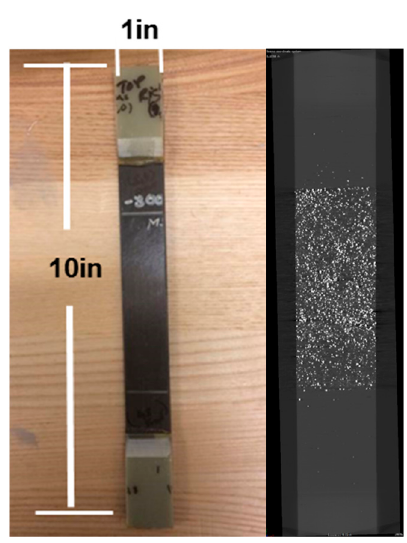
Figure 1. X-ray Micro CT image of the IM7/8552 CFRP with Terfenol–D particles.